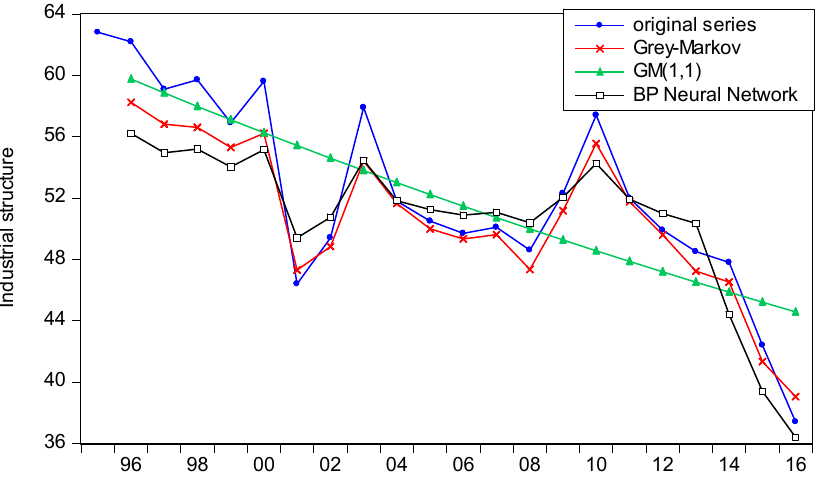
Figure 4. The forecasting results for industrial structure.